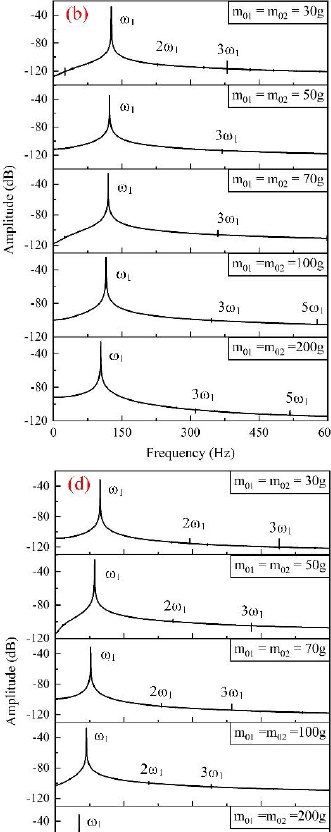
and 200 g) in l /4. ( b ) Symmetric additional masses (top to bottom: 30 g, 50 g, 70 g, 100 g, and 200 g) 203